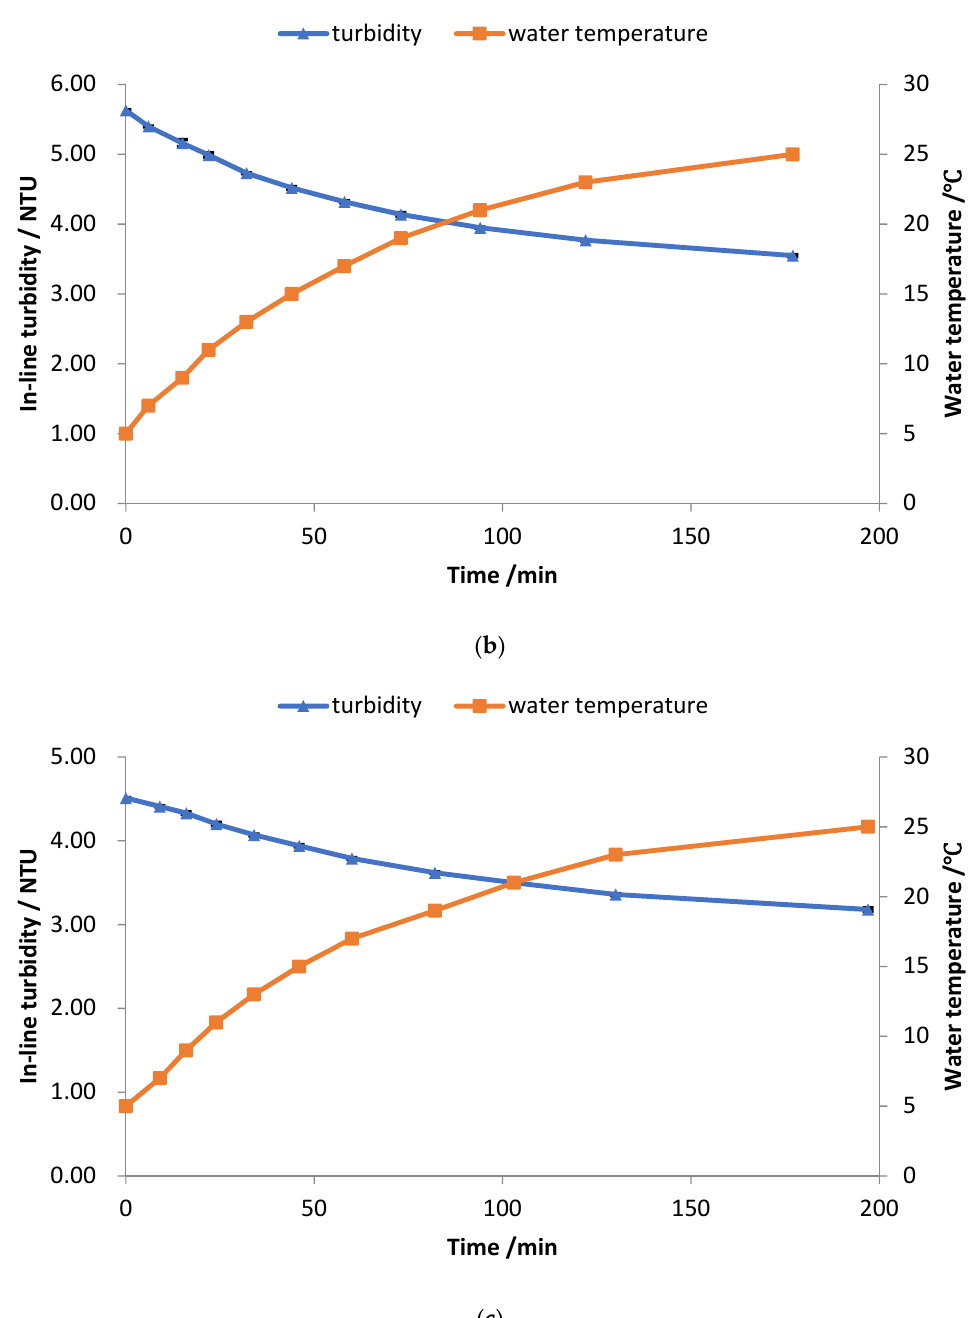
Figure 5. Relationship between the in-line turbidity and water temperature over time after the water cooling treatment. ( a ) Water velocity is set as 0.33 m/s. ( b ) Water velocity is set as 0.66 m/s. ( c ) Water velocity is set as 1.66 m/s.